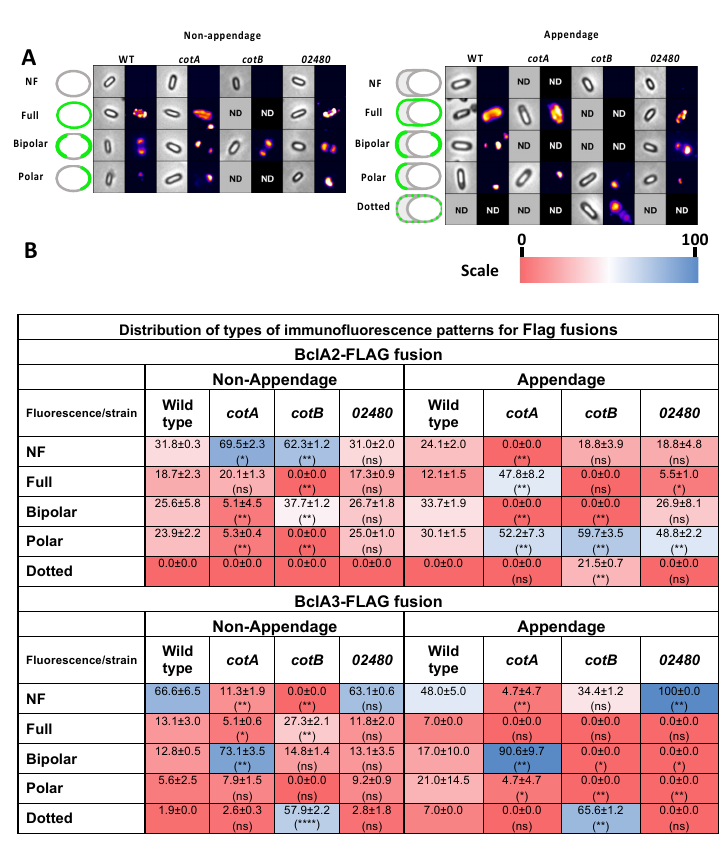
Figure 6. Effect of absence of spore coat proteins in accessible immunofluorescence of collagen- like BclA-Flag fusions. ( A ) Representative image of the distribution of fluorescent distribution pattern of BclA2-FLAG on the surface of non-appendage or appendage spores of Wildtype and cotA (cotA::CT555a ), cotB ( cotB::CT329a ) and CDIF630_02480 ( CDIF630_02480::CT90a ) mutant strains. ( B ) Quantification of fluorescence patterns in non-appendage or appendage spores of wildtype cotA , cotB or cotCB strains which were first binned by presence or absence of appendage through phase contrast microscopy prior to fluorescence analysis. Data represent the mean and error bars represent the standard error of the mean. Asterisks denote statistical difference with respect to wildtype (ANOVA and Bonferroni multiple comparison test), where * p < 0.05, ** p < 0.01, **** p < 0.0001, and n.s., denotes no significant difference. Heat map depicts the percentage of total of the fluorescence distribution from 0 to